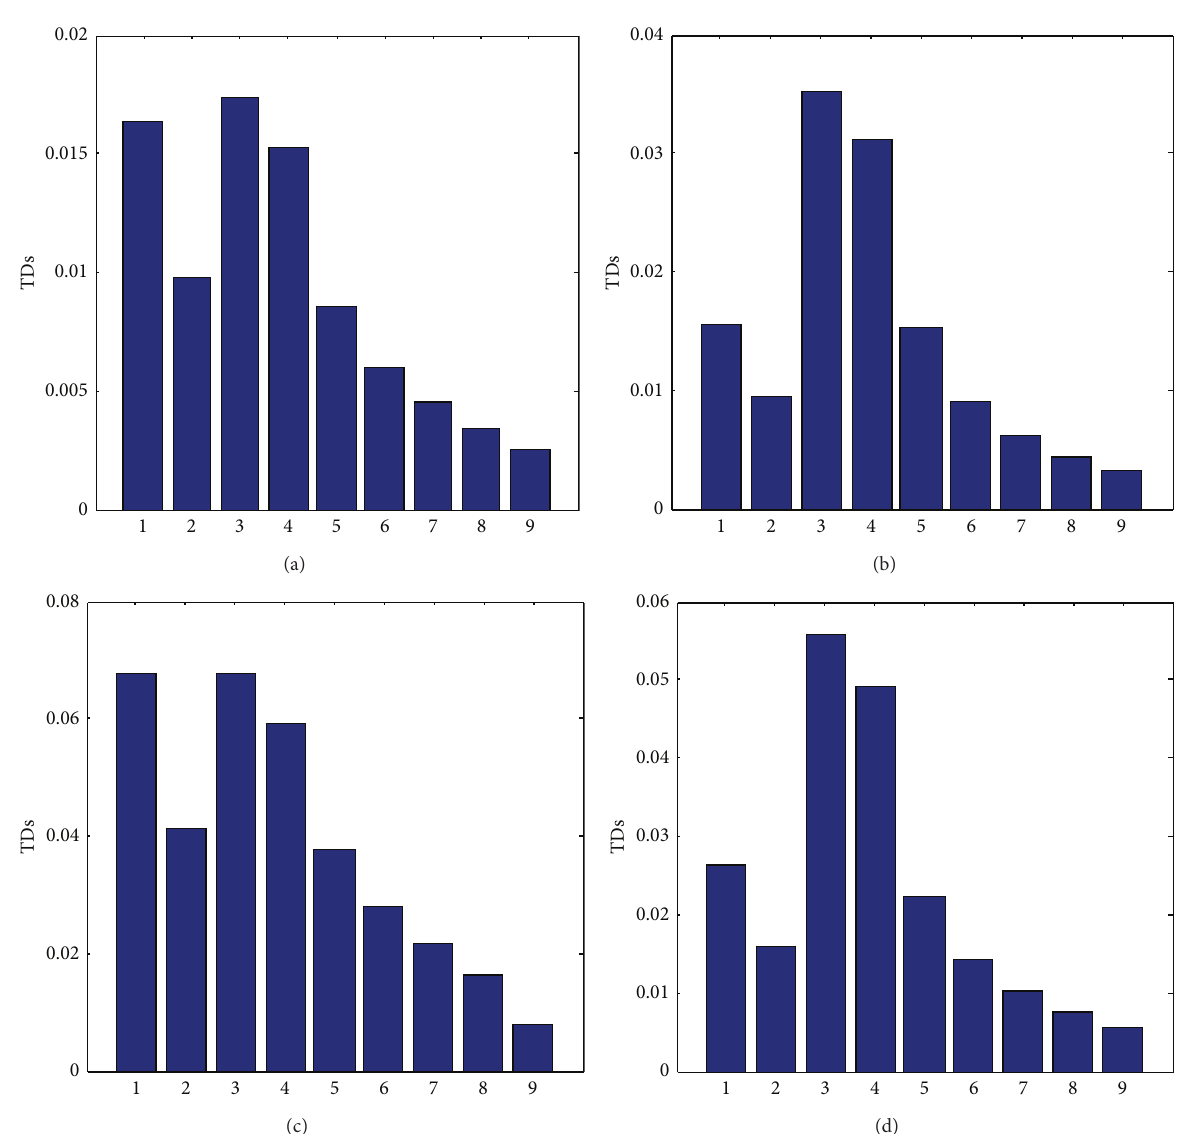
Figure 9: Detection indicators of the cantilever beam for 0–50 Hz with different crack depth ratios: (a)–(d) are the indicators with 𝛾 from 0.1 to 0.4,